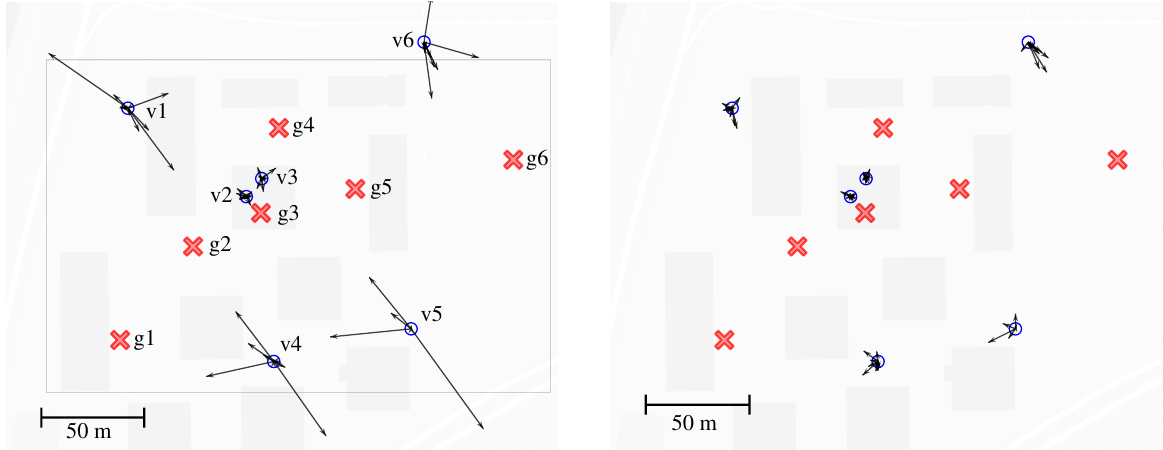
Figure 7: Error of the verification points, both for the reconstruction without (left) and with (right) the rolling shutter model. The red crosses depict the GCPs. The arrows are centered on the verification points and their lengths and directions show the X-Y error for each of the datasets listed in Tab. 3. The circle centered on each verification point shows the GSD in the same scale as the arrows. On the left image, the rectangle shows the contours of the flight path.